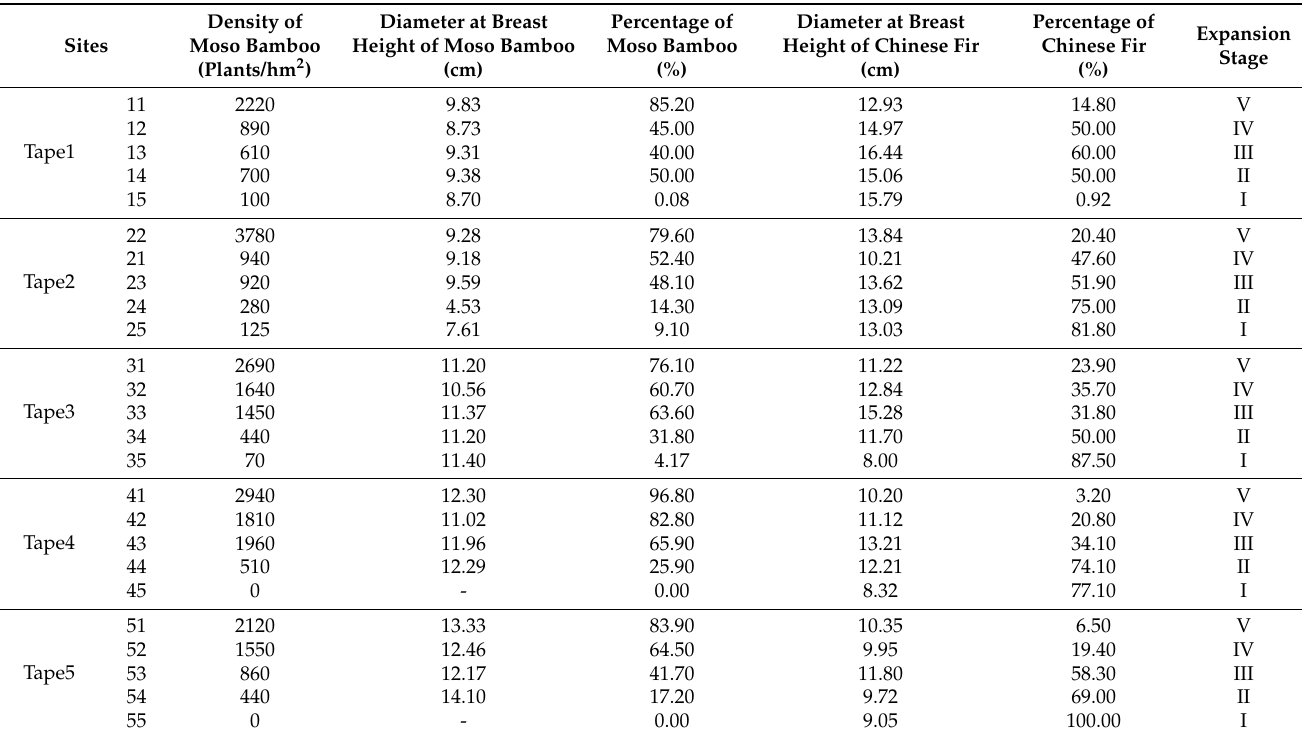
Table 1. Basic information on belt transect settings for different stages of Moso bamboo ( Phyllostachys edulis (Carriere) J. Houzeau) expansion into Chinese fir ( Cunninghamia lanceolata (Lamb.) Hook.)